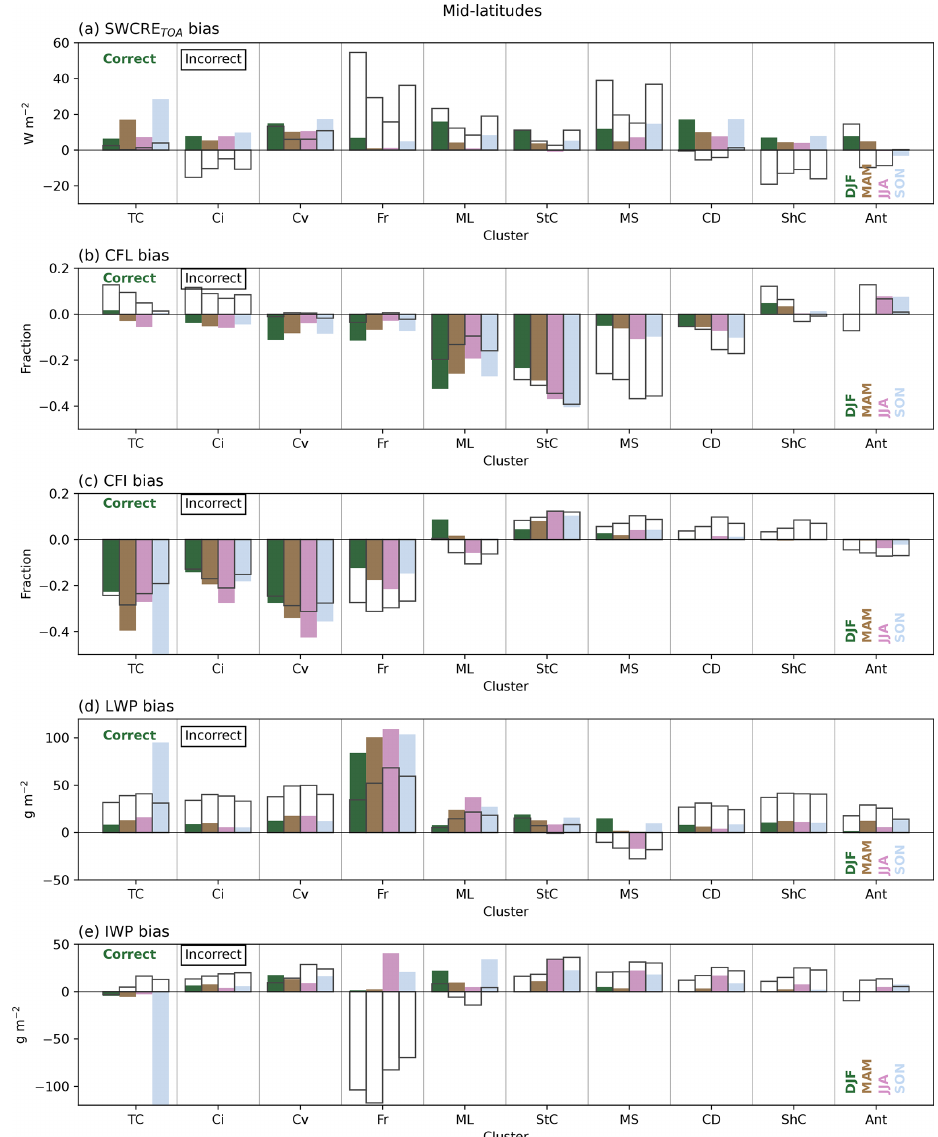
Figure 8. (a) Mid-latitude SWCRE TOA biases (Wm − 2 ) averaged over each cloud cluster (thin cirrus, TC; cirrus, Ci; convective, Cv; frontal, Fr; mid-level, ML; stratocumulus, StC; marine stratiform, MS; cloud decks, CD; shallow cumulus, ShC; Antarctic, Ant), seasonally (DJF, dark blue; MAM, green; JJA, pink; SON, light blue), for instances when the MODIS clusters are correctly assigned (coloured bars) and incorrectly assigned (black outline) by ACCESS-AM2 for the mid-latitude region. Panels (b) – (e) show the same as plot (a) but for the CFL (fraction), CFI (fraction), LWP (gm − 2 ) and IWP (gm − 2 ) biases